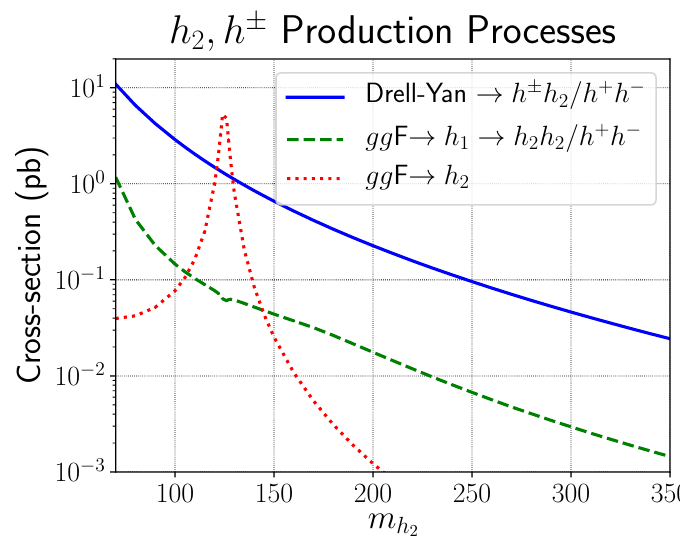
(cid:6) pair production cross sections via Drell-Yan processes (solid blue line) Figure 7. The total h 2 ; h or via an intermediate o(cid:11)-shell h 1 (green dashed line), as well as the single h 2 production cross section via gg F (dotted red line). The cross sections are shown for (cid:22) 2 = 200 2 GeV 2 and v (cid:6) = 1. (cid:6) The peak in the single h 2 production cross at m h 125 GeV occurs due to an increase in the 2 (cid:25) neutral scalar mixing angle when the two neutral scalars are nearly degenerate, and not due to an s -channel